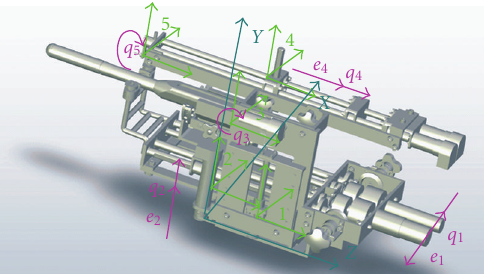
Figure 2: 5-DOF surgery module, absolute and local coordinate systems together with generalized coordinates q i